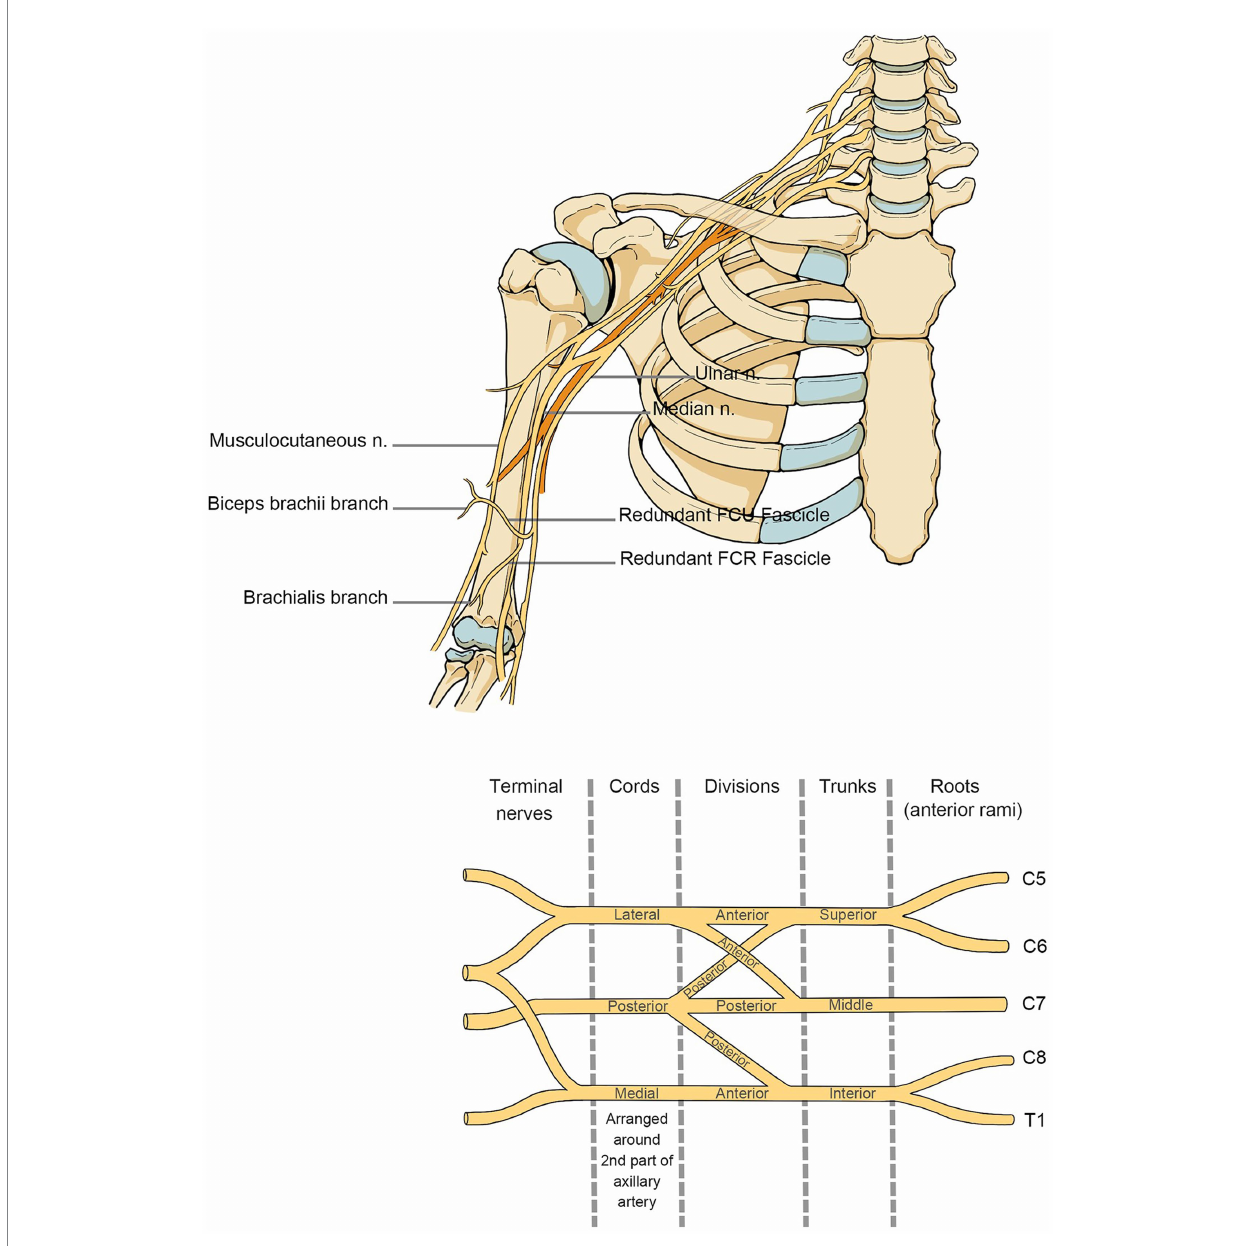
FIGURE 1 Anatomy of the brachial plexus nerve. The anatomical course of the brachial plexus nerve in the shoulder, neck and upper